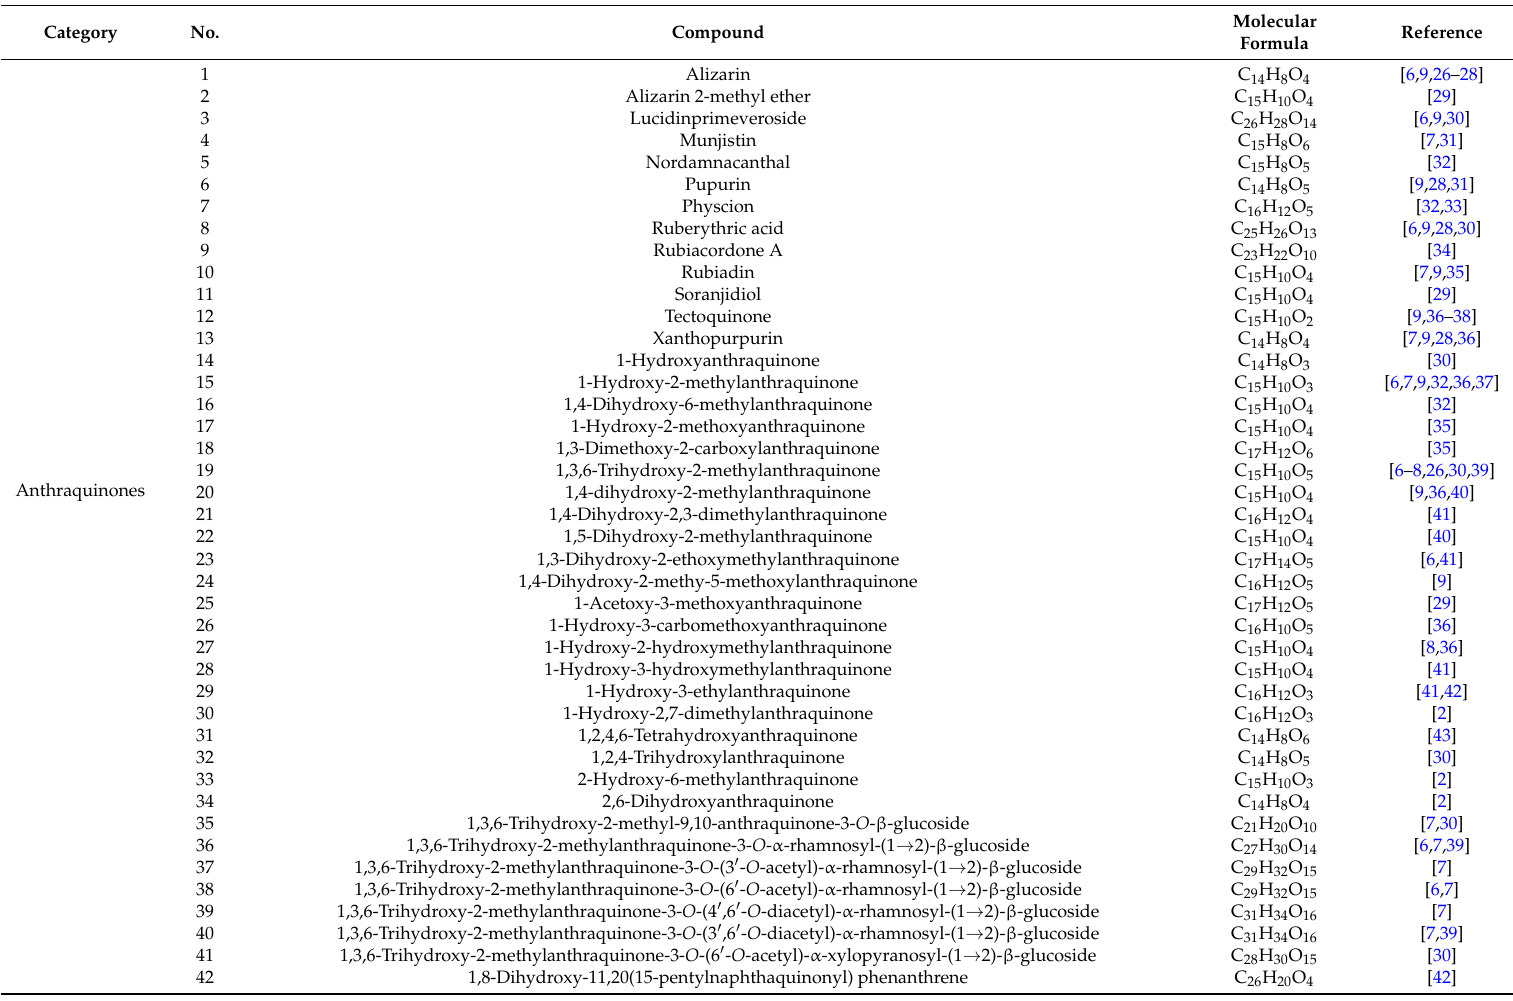
Table 1. Compounds in Rubiae Radix et